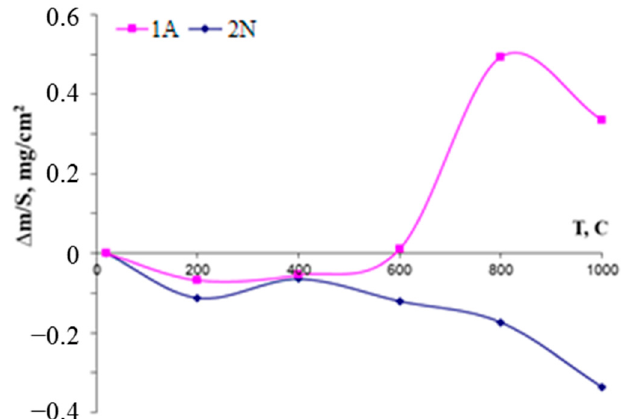
Figure 11. Weight changes of Coatings 1A and 2N in relation to the annealing temperature.